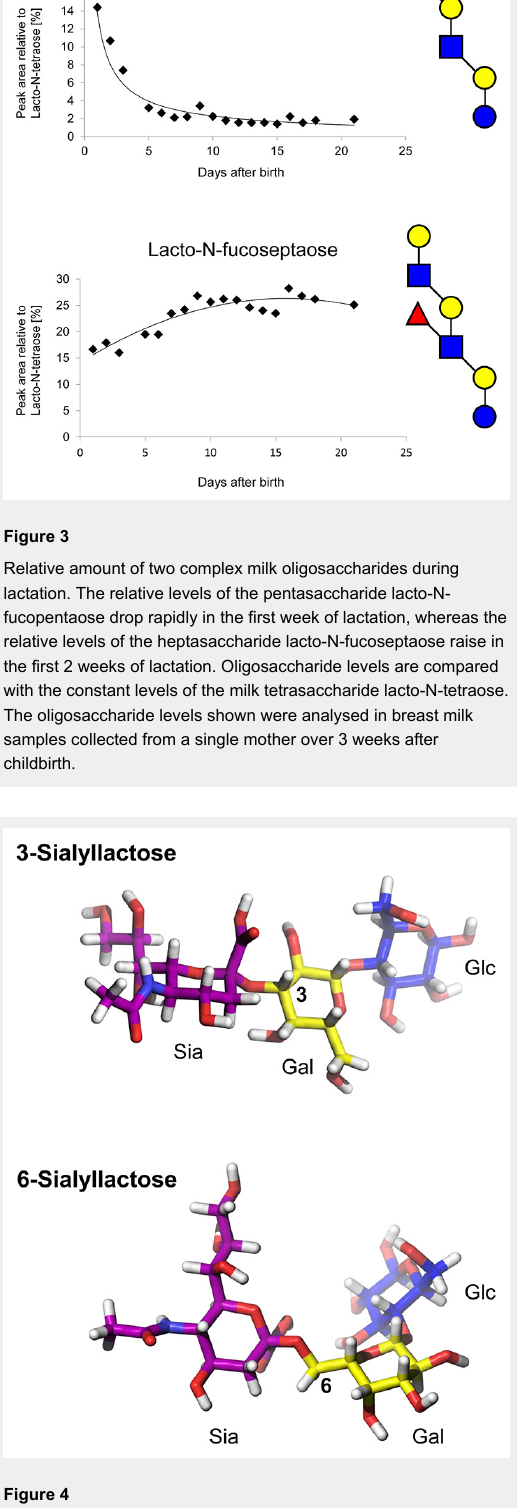
Structure of 3–sialyllactose and 6–sialyllactose. The three- dimensional structures point to the extended configuration of 3–sialyllactose and bent configuration of 6–sialyllactose. The positions of the third and sixth C-atoms of galactose (Gal), to which sialic acid (Sia) is attached are marked with the numbers 3 for 3–sialyllactose and 6 for